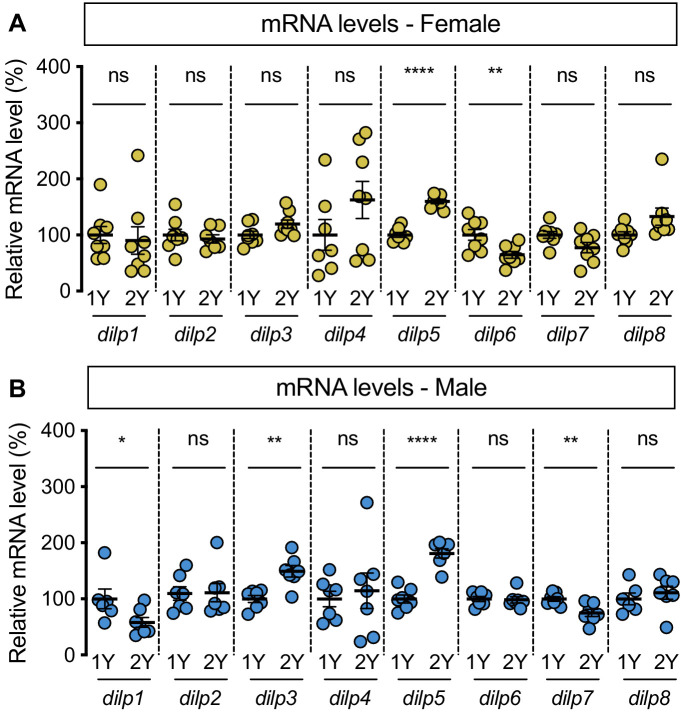
Diet-dependent changes to dilp mRNA levels.(A) mRNA levels of dilp5 and dilp6 were significantly different between females raised on a protein-rich diet (2Y) compared with female larvae cultured on a diet with half the protein (1Y) (p<0.0001 and 0.0079, respectively; Student’s t test), but mRNA levels of dilp1, dilp2, dilp3, dilp4, dilp7, dilp8 were unchanged (p=0.7337, 0.5947, 0.0672, 0.1777, 0.0562 and 0.0643, respectively; Student’s t test). n = 7–8 biological replicates. (B) In males cultured in 1Y, mRNA levels of dilp1, dilp3, dilp5, dilp7 were significantly different from male larvae raised on 2Y (p=0.047, 0.0014,<0.0001, and 0.0068, respectively; Student’s t test); mRNA levels of dilp2, dilp4, dilp6, and dilp8 were unchanged (p=0.9388, 0.6812, 0.8157 and 0.5054, respectively; Student’s t test). n = 6–7 biological replicates. * indicates p<0.05, ** indicates p<0.01, **** indicates p<0.0001; ns indicates not significant; error bars indicate SEM.